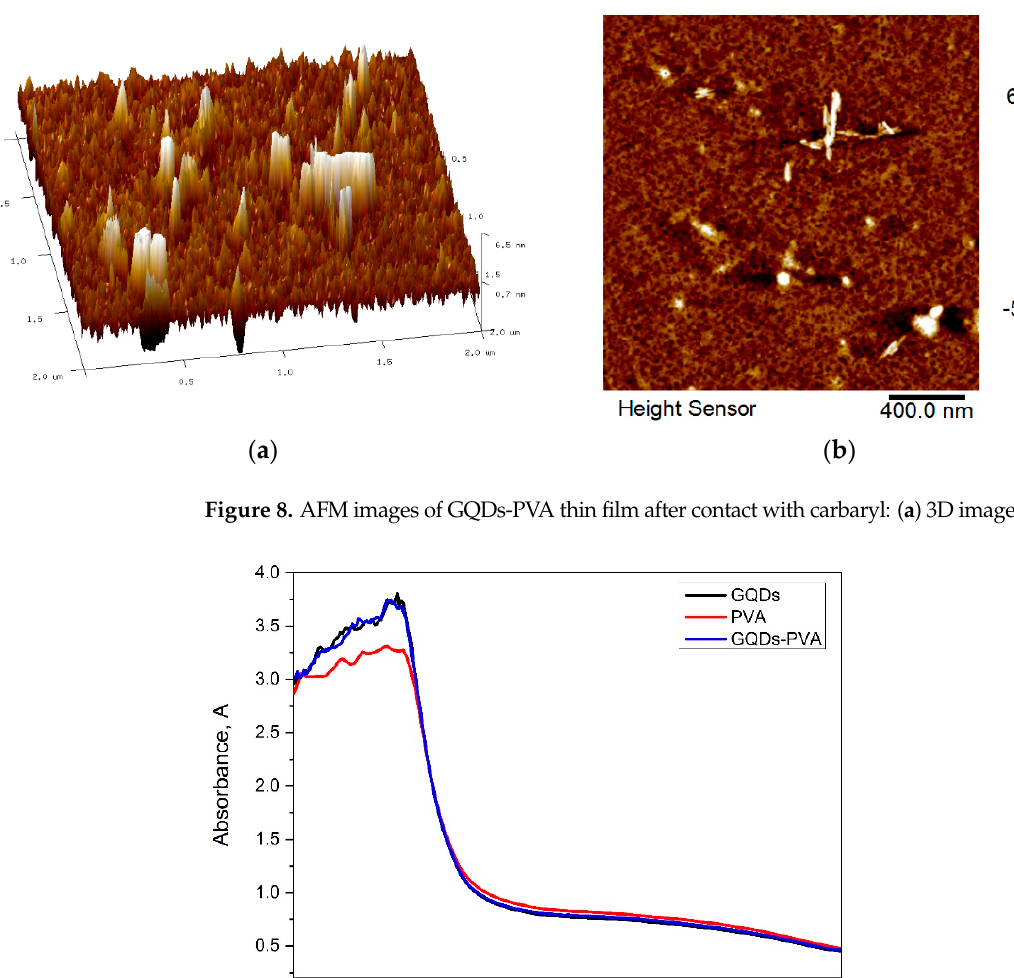
Figure 8. AFM images of GQDs − PVA thin film after contact with carbaryl: ( a ) 3D image and ( b ) 2D image.